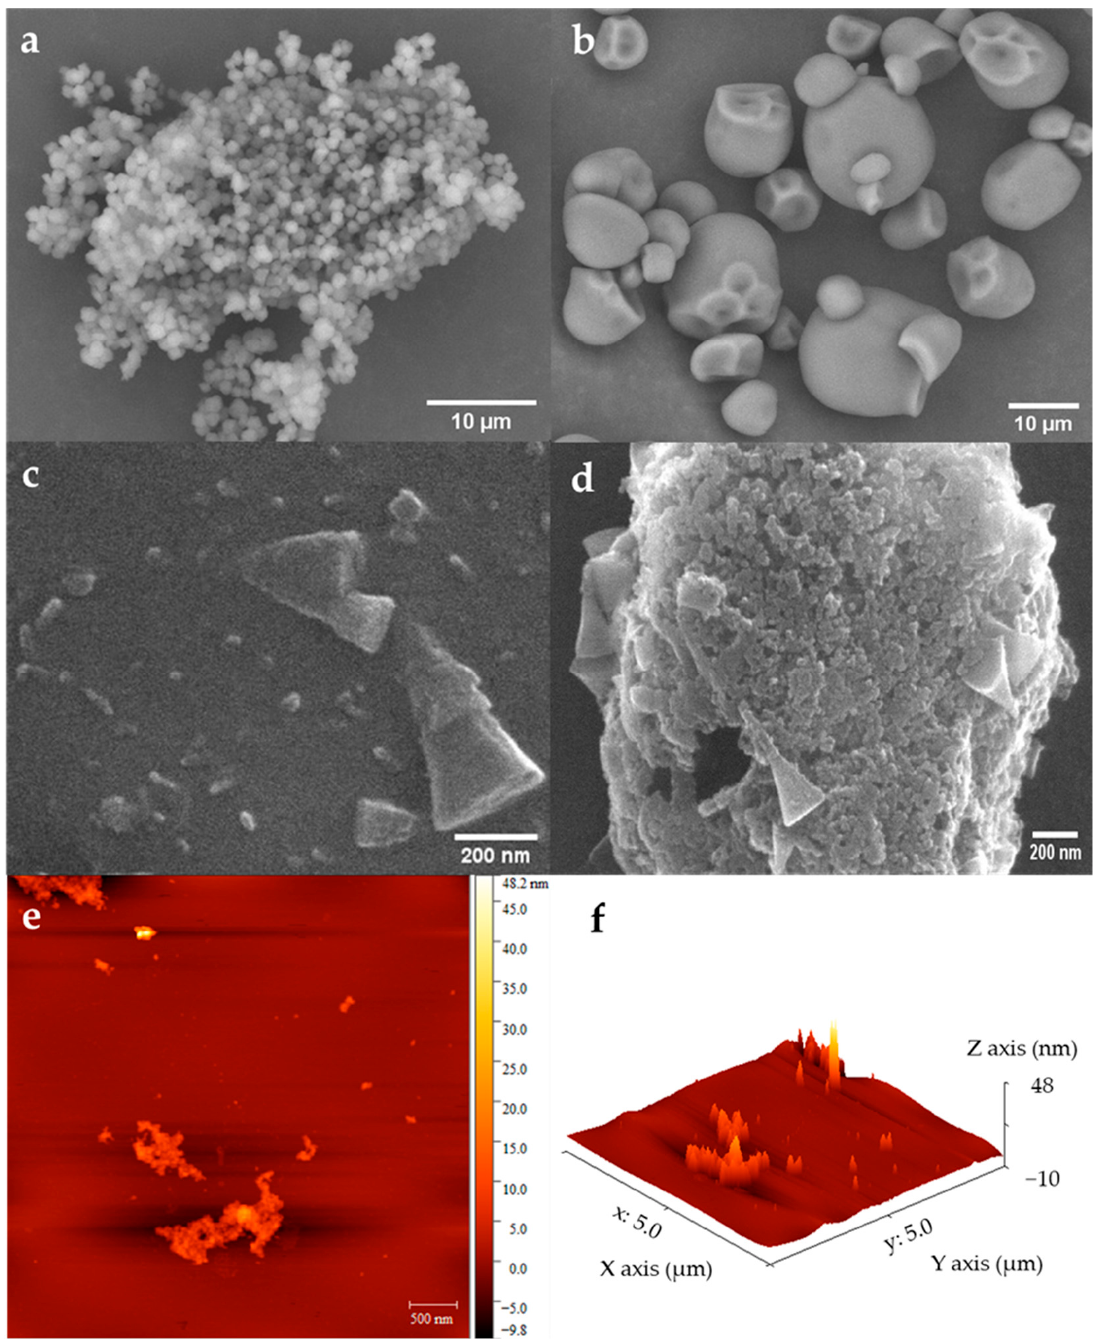
Figure 1. Micrographs of native starches and quinoa starch nanocrystals: ( a ) quinoa starch and ( b ) cassava starch by SEM; ( c ) quinoa starch nanocrystals and ( d ) quinoa starch nanocrystals aggregate by SEM-FEG; ( e ) 2D and ( f ) 3D quinoa starch nanocrystals by AFM.